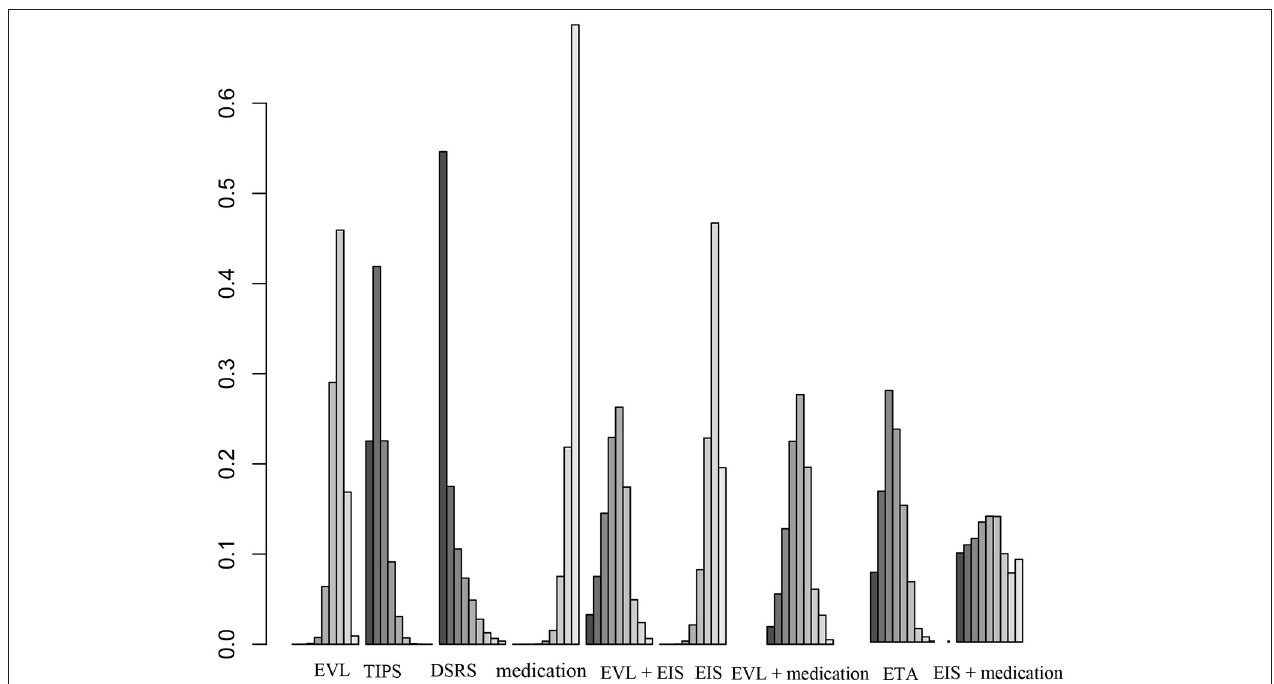
FIGURE 4 | Ranking of therapies based on all-cause rebleeding. EVL, endoscopic variceal ligation; TIPS, transjugular intrahepatic portosystemic shunt; DSRS, distal splenorenal shunt; EIS, endoscopic injection sclerotherapy; ETA, endoscopic tissue.